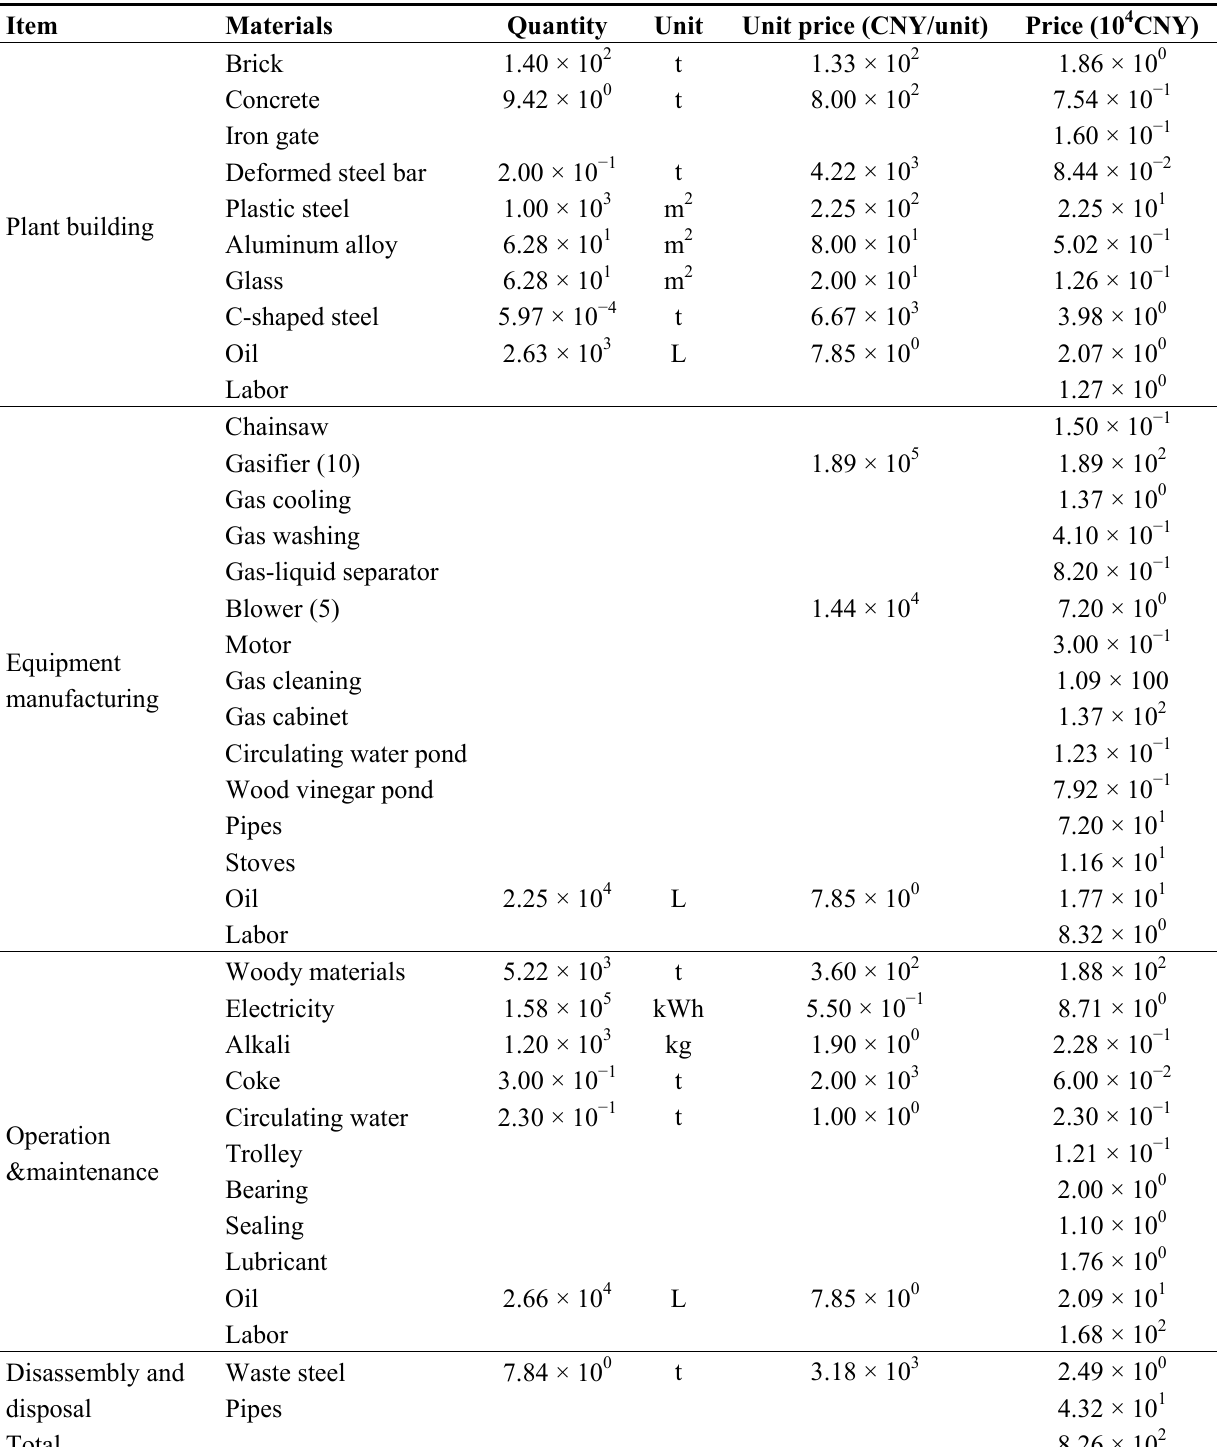
Table 1. The inventory of various inputs used in the village-level gasification